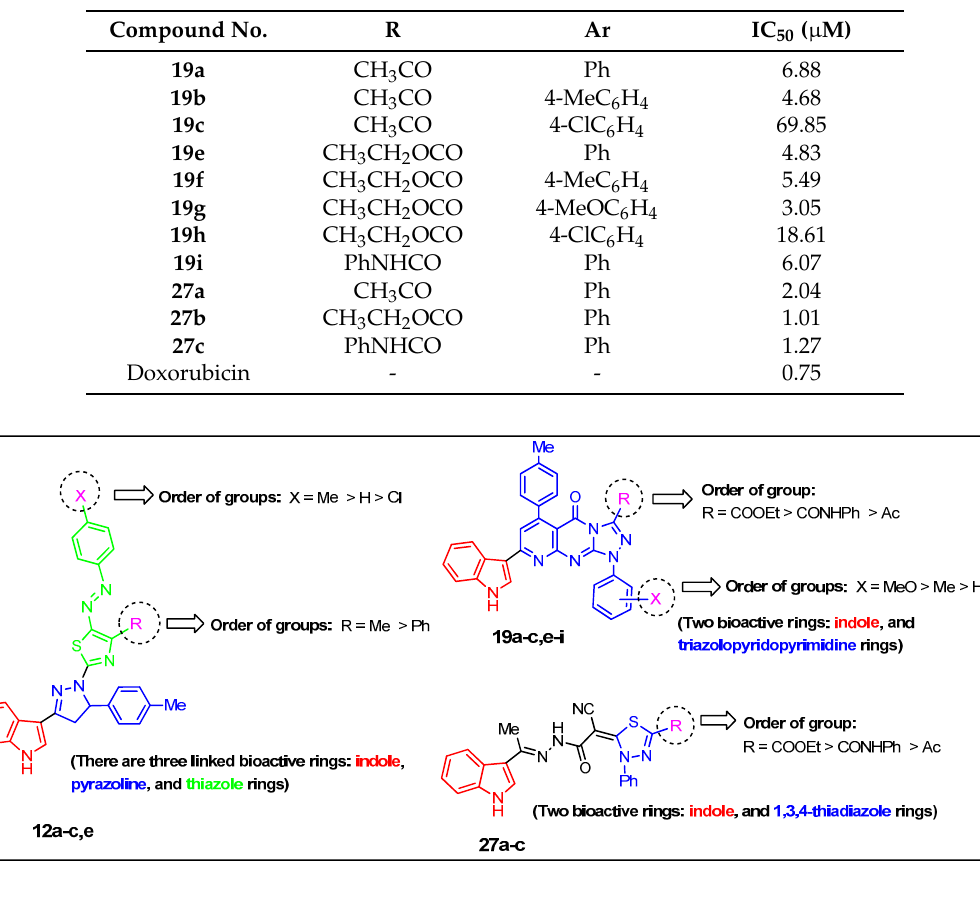
Figure 2. Activities of tested compounds against the MCF ‐ 7 breast cancer cell line.